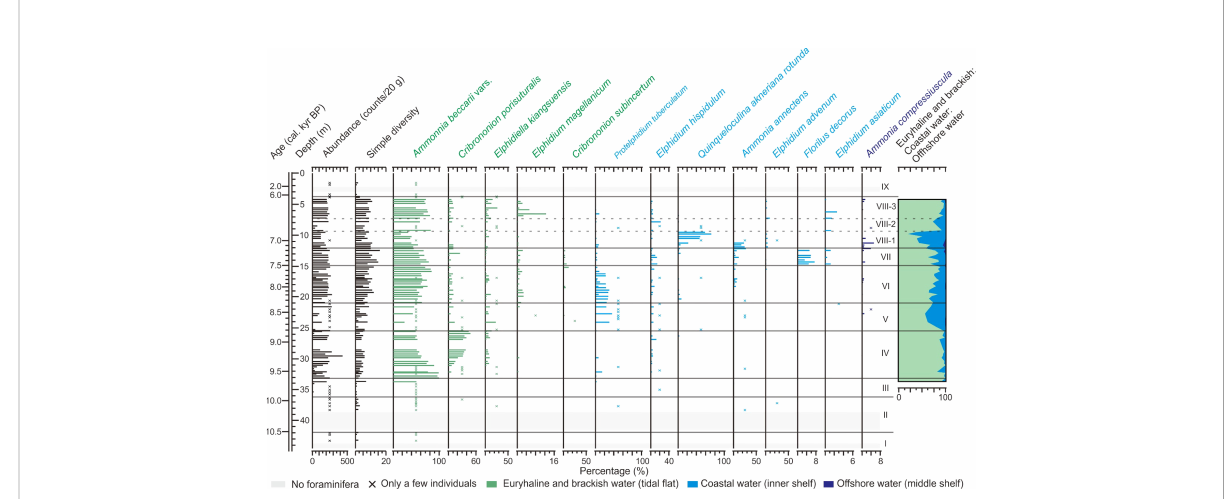
FIGURE 6 Vertical distribution of absolute abundance, simple diversity, and relative abundances of major foraminiferal species in core XY. The ratios of euryhaline and brackish water species, coastal water species, and offshore water species are also